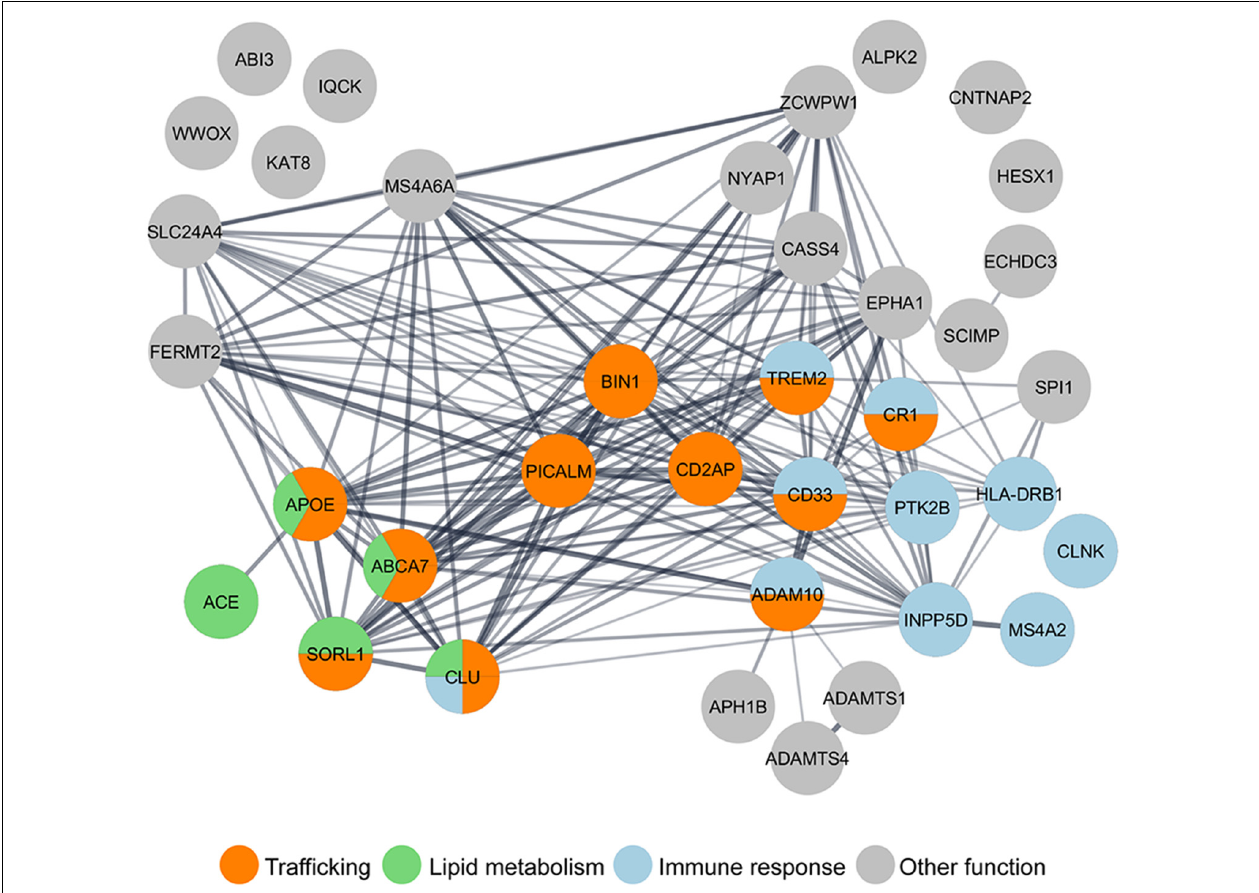
FIGURE 1 | Gene ontology (GO) analysis of LOAD risk factors reveals the enrichment of genes in the trafficking pathway. Nearly half of the 37 LOAD putative risk factors identified by genome-wide association studies (GWAS) meta-analysis (Lambert et al., 2013; Jansen et al., 2019; Kunkle et al., 2019), have been functionally grouped by GO analysis in three main pathways: trafficking (orange), immune response (blue), and lipid metabolism (green). GO analysis was performed using the Cytoscape StringApp (Doncheva et al.,